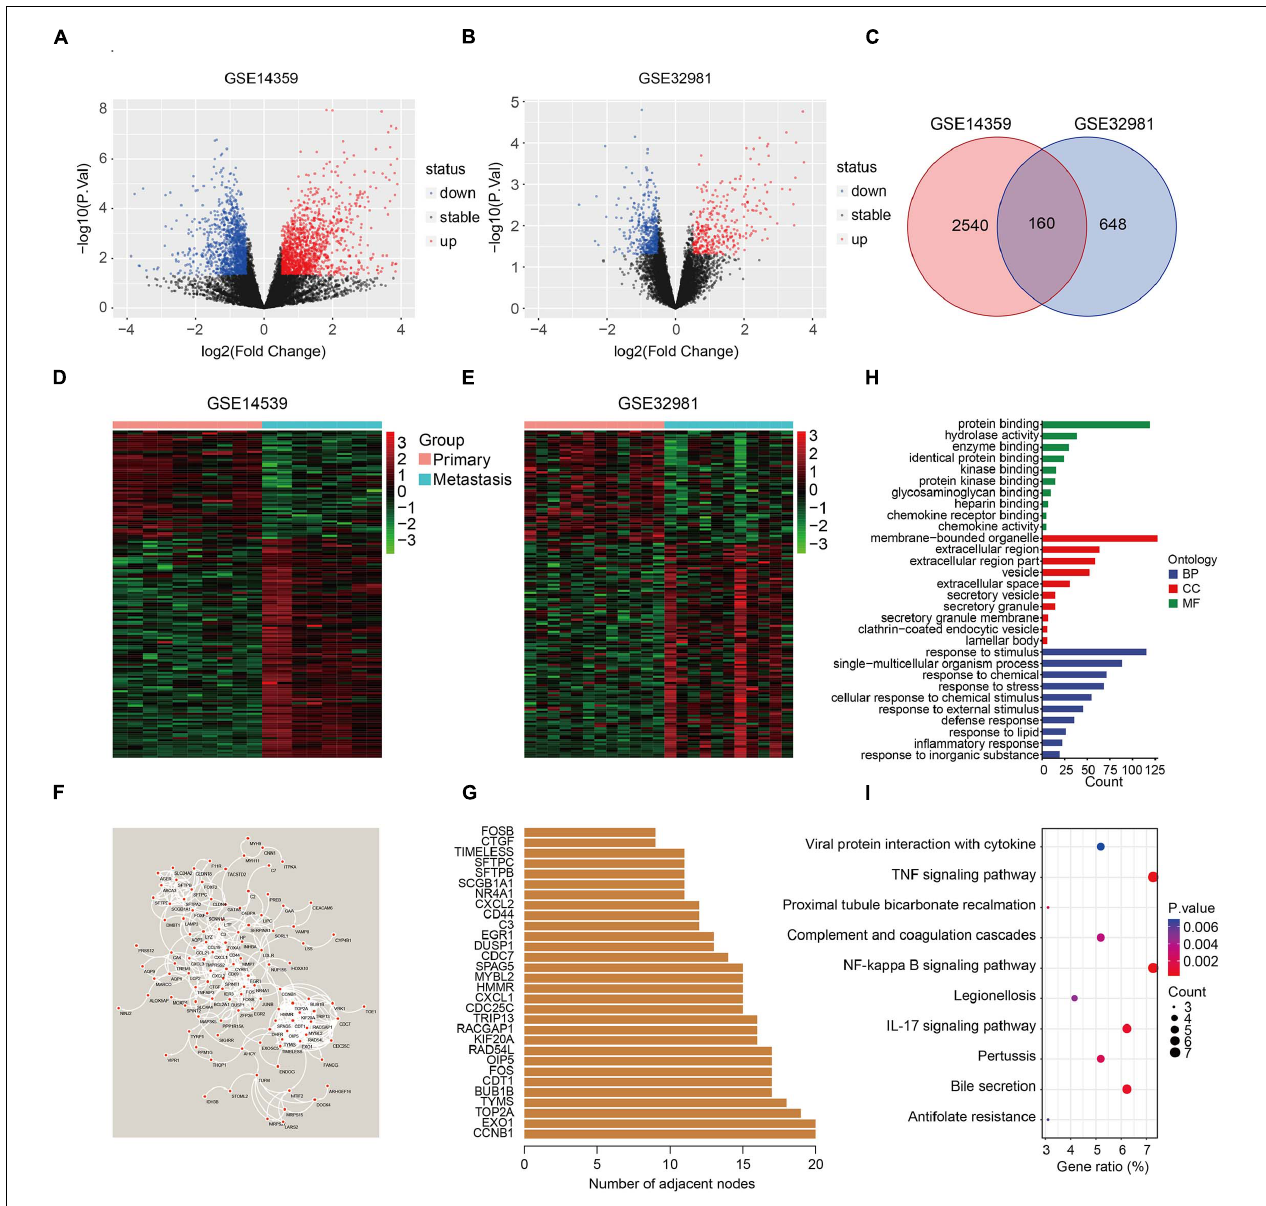
FIGURE 2 | Identification of metastasis-related genes and functional enrichment analysis. (A,B) Volcano plot showing differentially expressed genes between primary and metastatic osteosarcoma. (C) Venn diagram of metastasis-related genes in osteosarcoma. (D,E) Heatmaps of metastasis-related genes in the GSE14539 and GSE32981 datasets. (F) Construction of a protein-protein interaction network using the metastasis-related genes. (G) The number of adjacent nodes of the metastasis-related genes. (H) GO analysis of the metastasis-related genes. (I) KEGG pathway enrichment analysis of the metastasis-related genes.